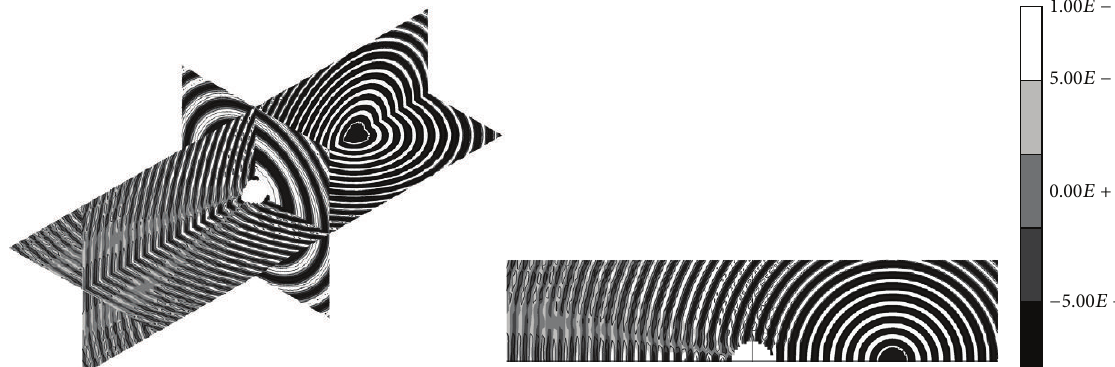
Figure 8: Instantaneous pressure distribution (Coarse mesh) around a sphere of diameter D